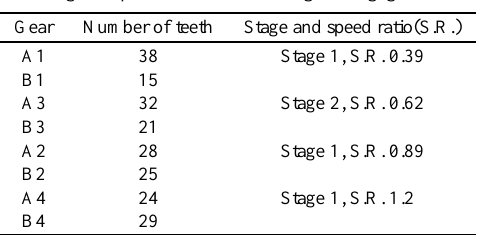
Table 1 The gears specification and the stage of engagement